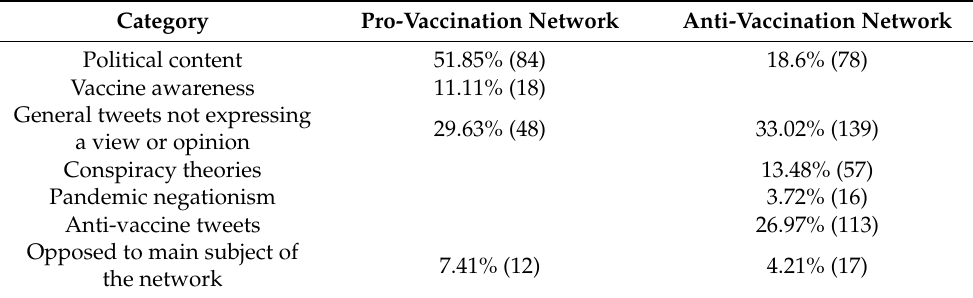
Table 3. Categorization of messages in the pro- and anti-vaccination network